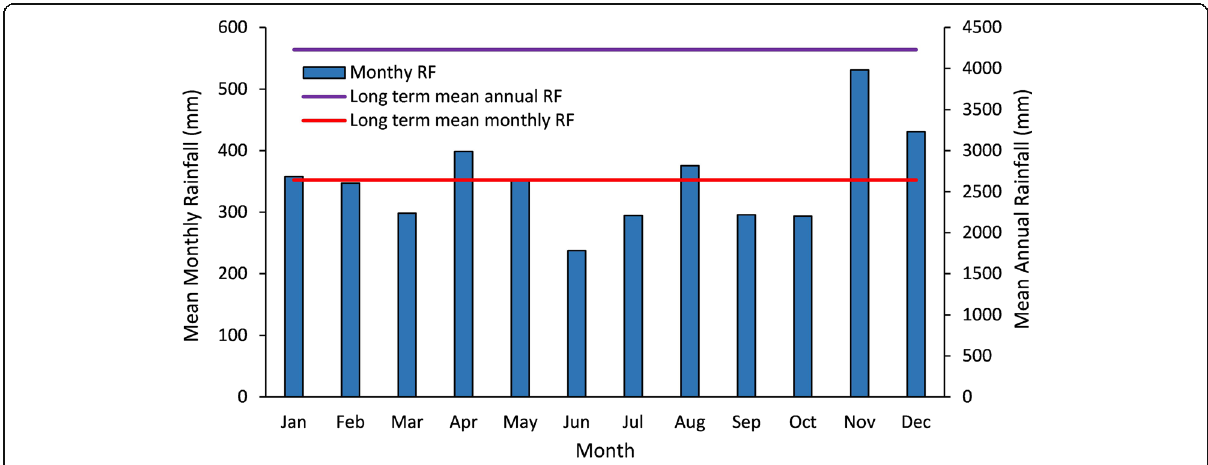
Fig. 6 Mean monthly and annual rainfall distribution in the study area